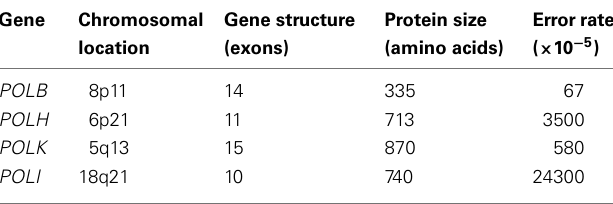
Table 1 | Human translesion synthesis DNA polymerase genes.